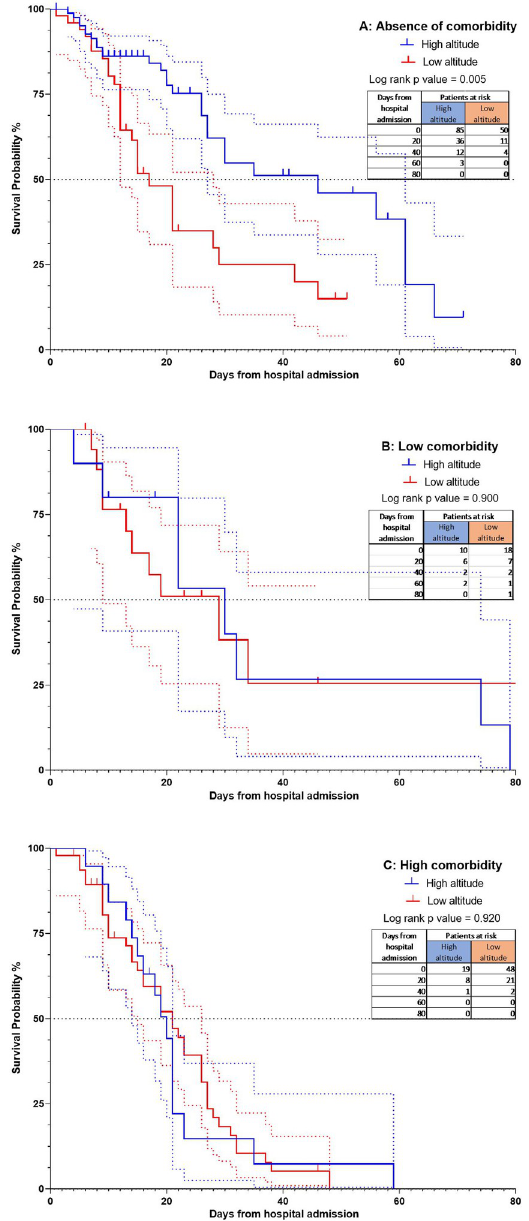
Fig 4. The Kaplan-Meier curves for mortality according to altitude and group analysis using the Charlson index. 4A Curve with absence of comorbidities p = 0.005; 4B Curve with low comorbidities p = 0.900; 4C Curve with high comorbidities p = 0.920. All comparisons were calculated with COX regression multivariate analysis.